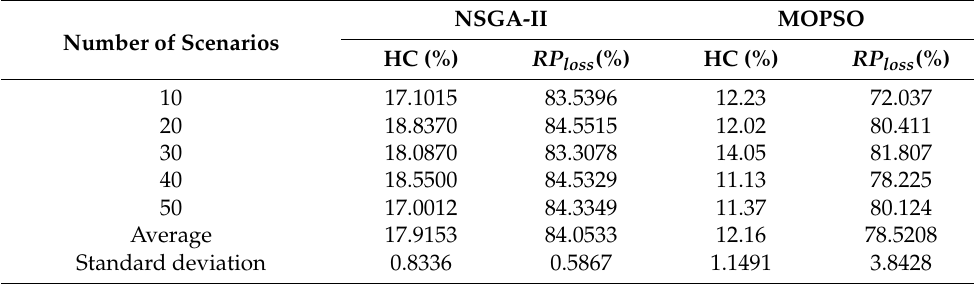
Table 13. The obtained HC and power loss reduction at different number of scenarios.